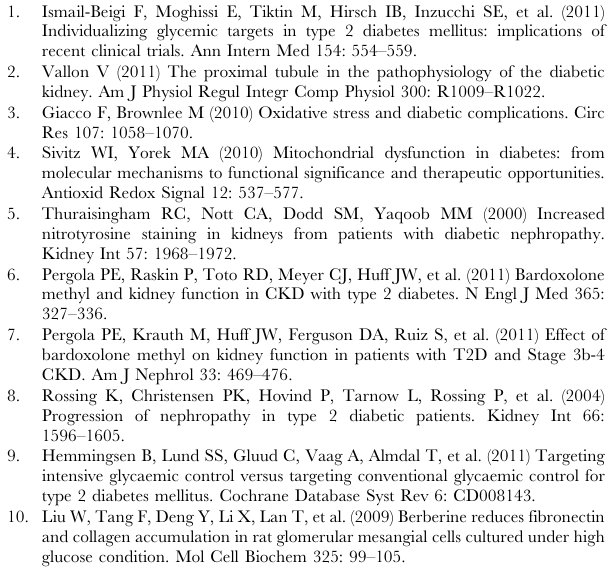
Figure S1 Effects of HFD and 17-DMAG treatment on bodyweight and blood glucose levels of db/db